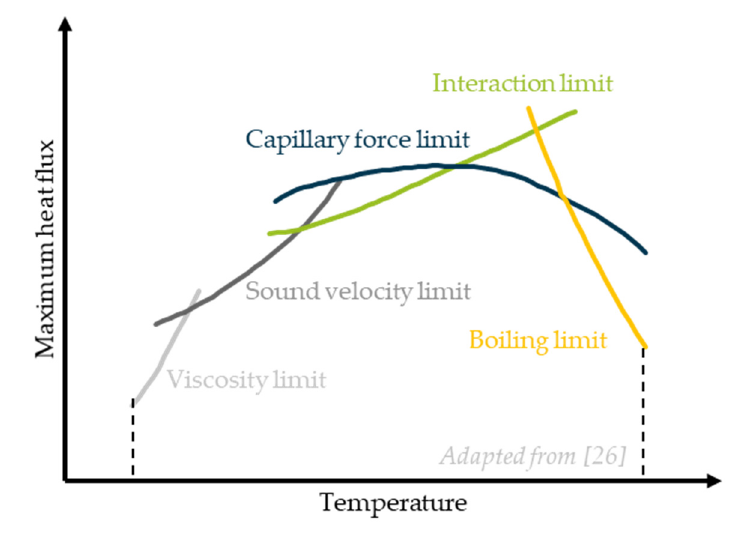
Figure 3. Performance restrictions of heat pipes [26].